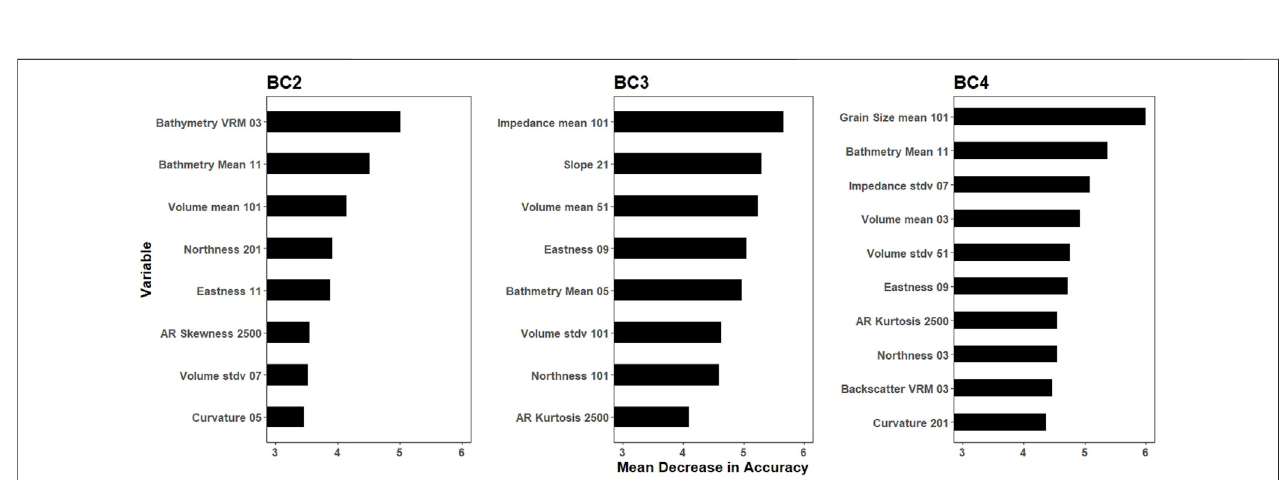
FIGURE8| Retainedmodelvariableimportancefor fi ne-scalesegmentation.Thehigher meandecrease accuracythemore important thevariableisforthemodel.